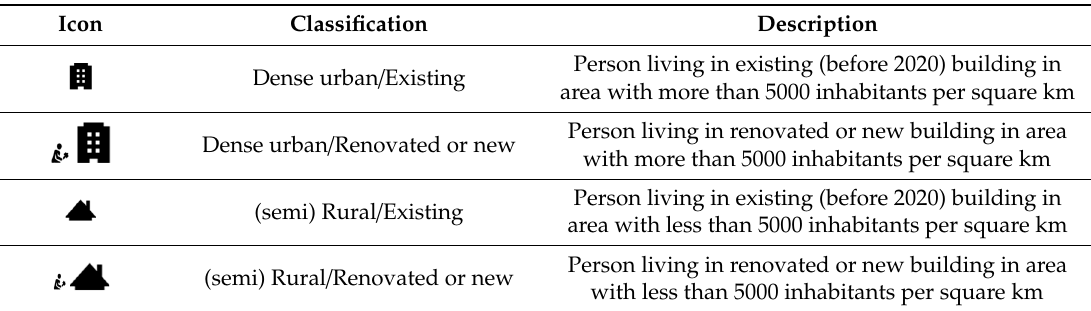
Table A4. Types of buildings in scenarios.